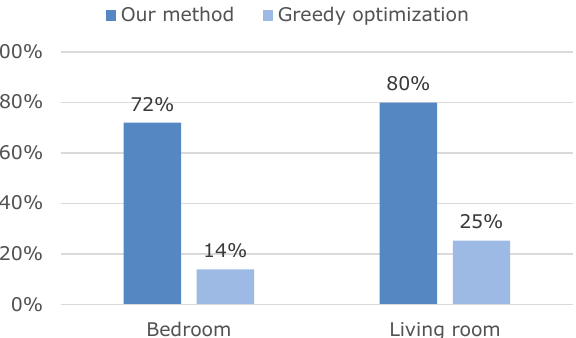
Figure 10. Results of our design sensibility study. The results indicate the probability of each algorithm to generate sensible furniture layout. Our algorithm achieves higher sensibility score in both